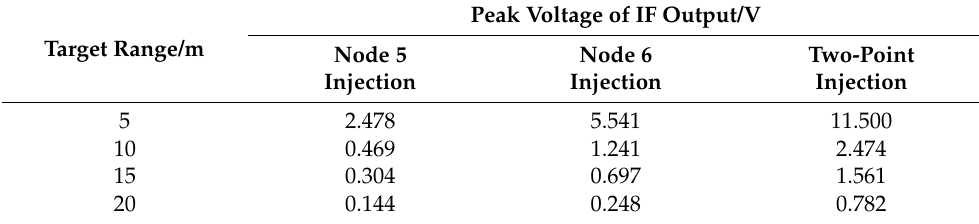
Table 6. Peak voltage of IF output of a single